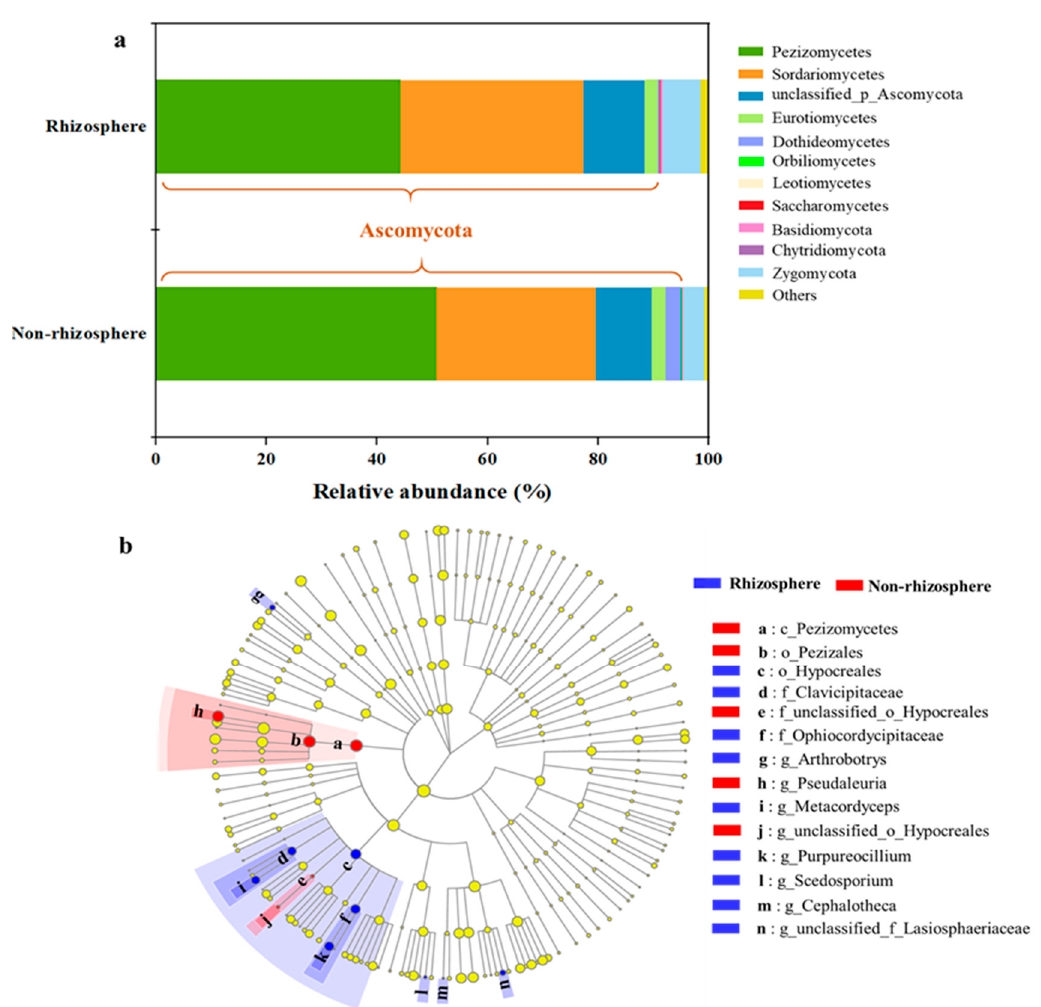
Figure 2. The abundance and composition of the fungal community at the phylum / class levels in soils ( a ). The response of the significantly fungal members from phyla to genera in the rhizosphere (blue) and non- rhizosphere soils (red) ( b ).